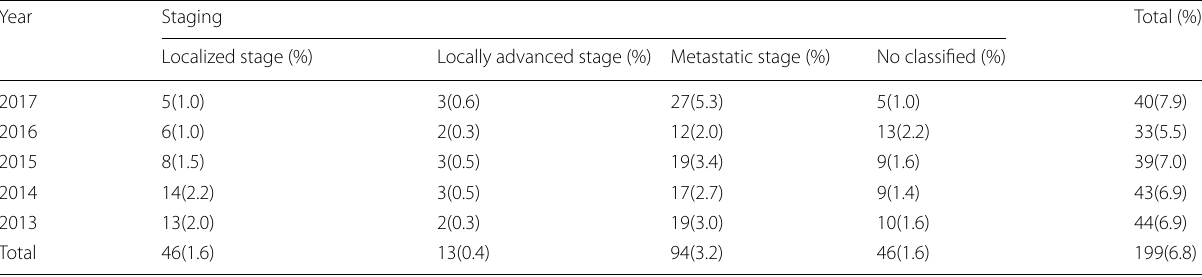
Table 2 Distribution of the total and annual incidences of cancer by stage Year